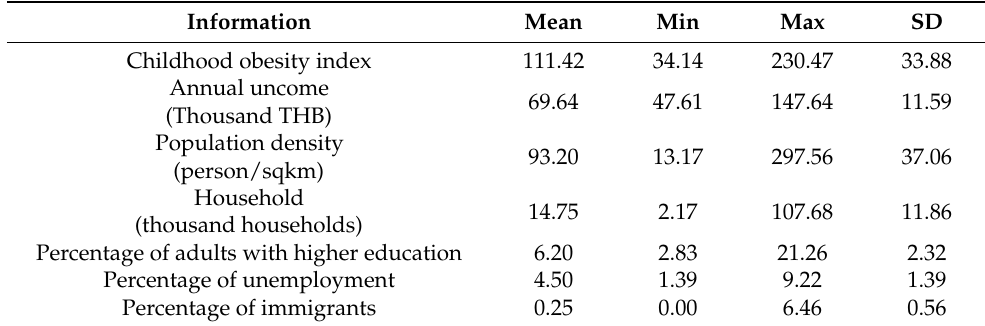
Table 2. Statistical results of the variables in the